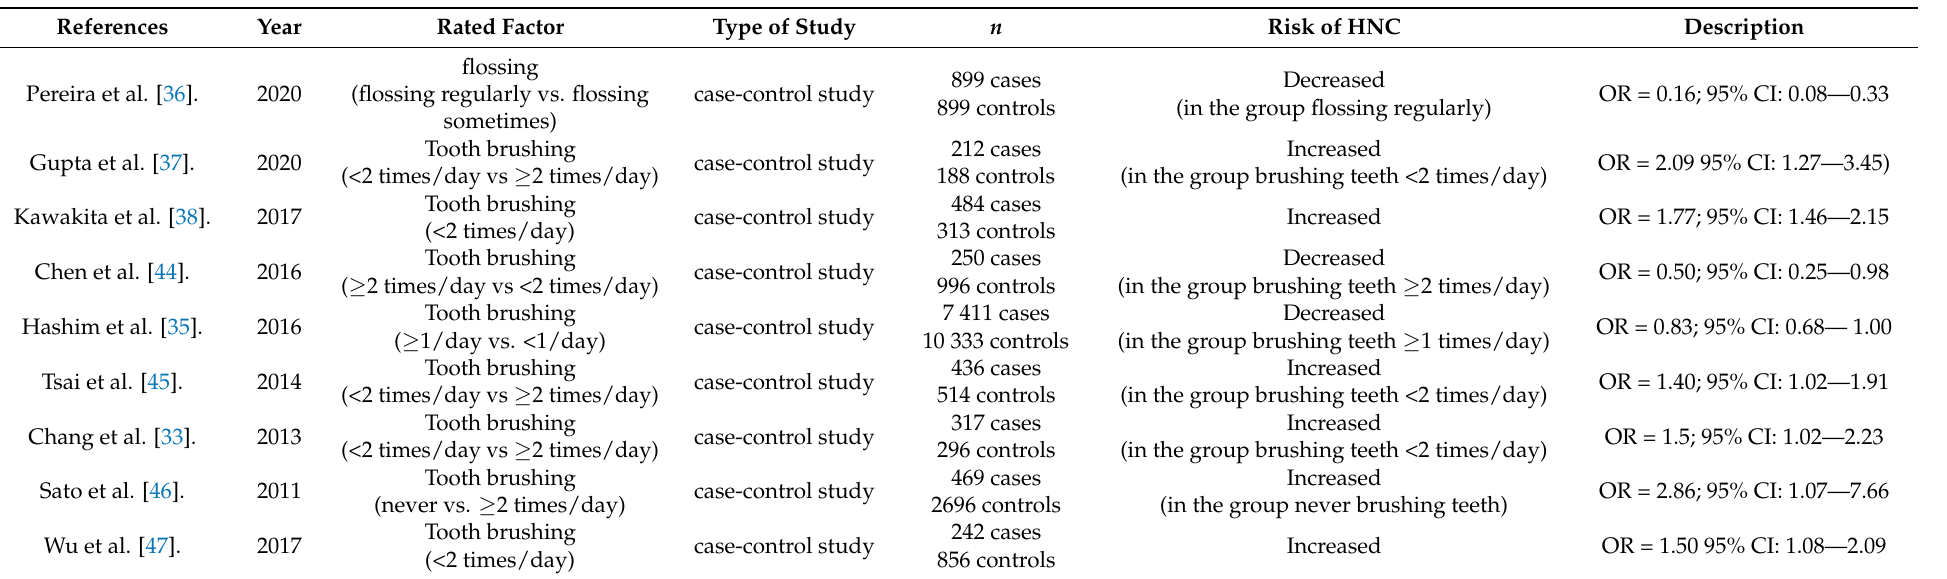
Table 4. The impact of oral hygiene habits on risk of developing head and neck squamous cell